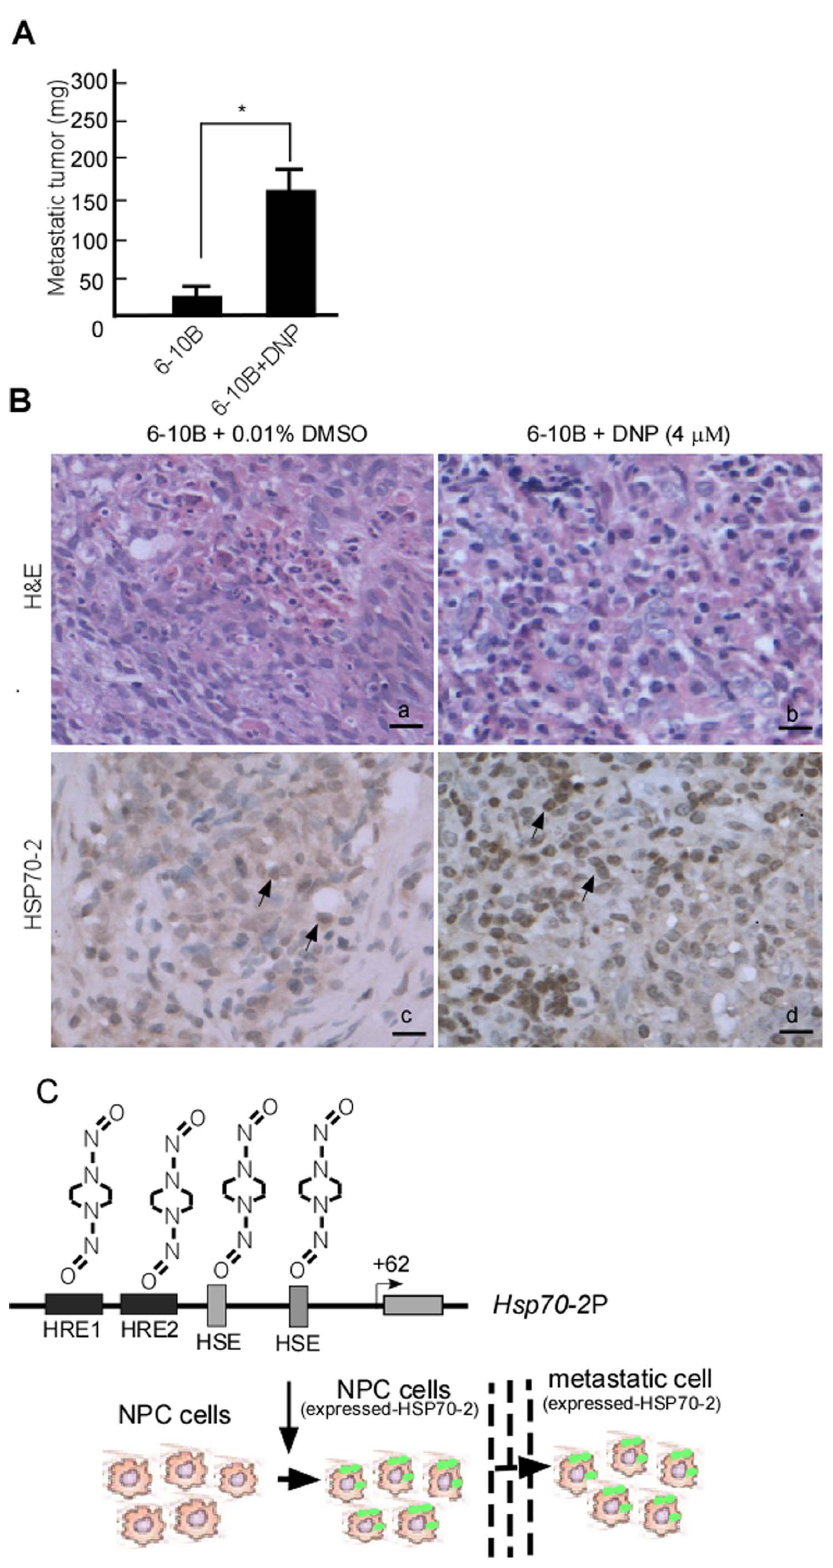
Figure 6. DNP-mediated NPC cell metastasis and HSP70-2 expression invivo . A, 20 BABL/c nude mice were injected with 6-10B cells in Matrigel through the tail vein (1 6 10 4 cells/mouse), and randomly divided into 2 groups (DNP-treated and control groups) with 10 mice per group. The DNP-treated group was abdominally injected using DNP at a dose of 40 mg/kg twice a week for 60 days. The control group was injected using 0.1% DMSO-PBS. After 60 days, metastatic tumors from the mediastinal lymph nodes were weighed (*, p , 0.05). B, HSP70-2 expression was detected